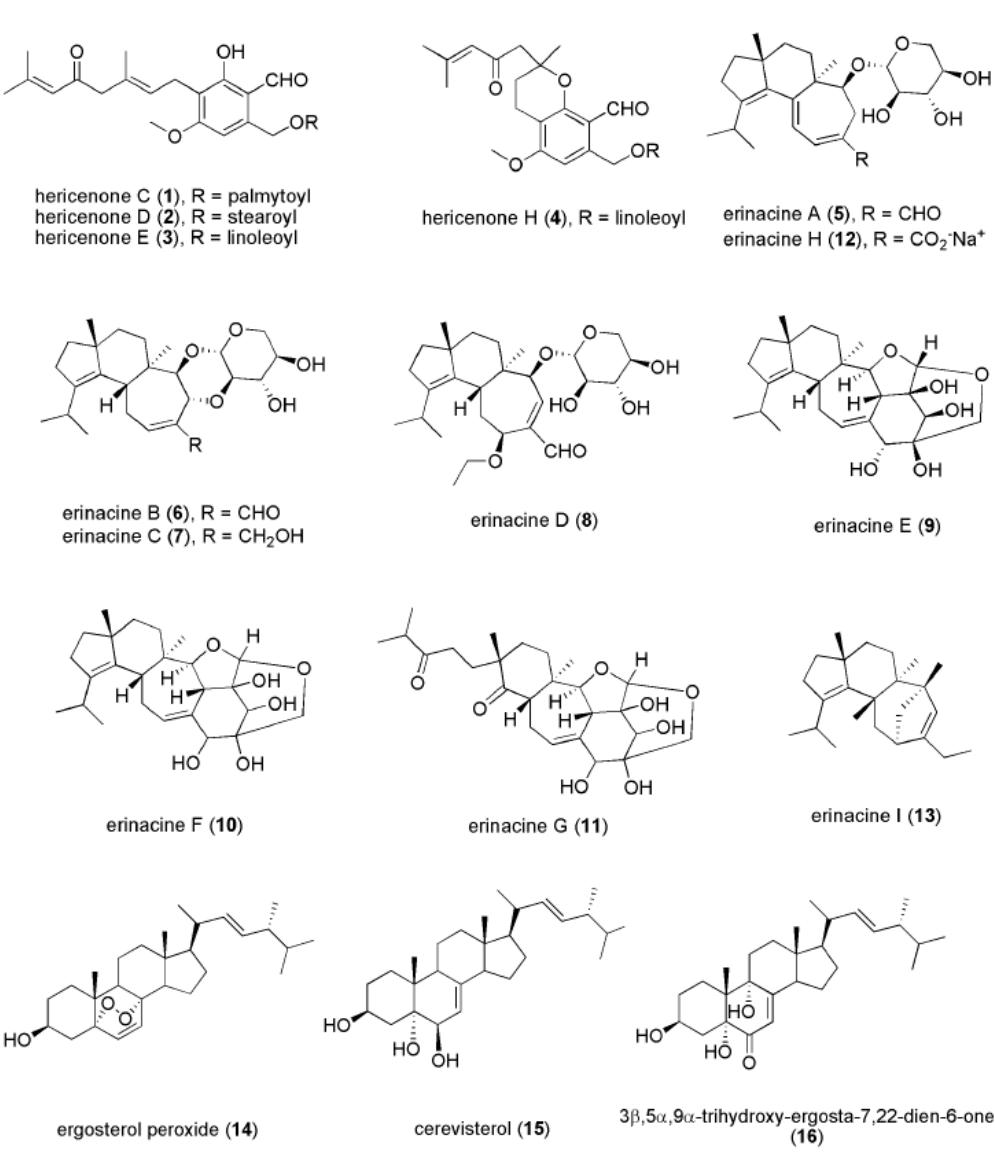
Figure 3. Chemical structures of hericenone C ( 1 ), D ( 2 ), E ( 3 ), H ( 4 ), erinacine A ( 5 ), H ( 12 ), B ( 6 ), C ( 7 ), D ( 8 ), E ( 9 ), F ( 10 ), G ( 11 ) , I ( 13 ), ergosterol peroxide ( 14 ), cerevisterol ( 15 ), and 3 β ,5 α -trihydroxy-ergosta-7,22-dien-6-one ( 16 ).